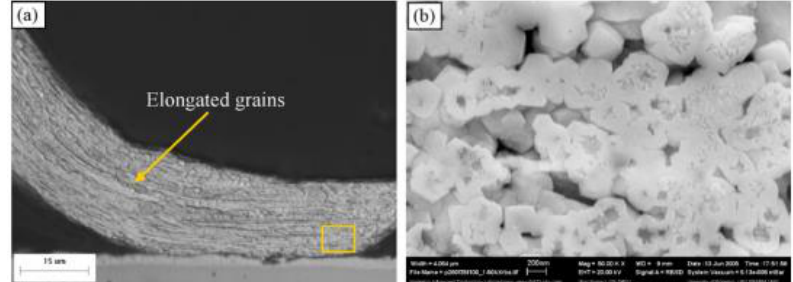
Figure 13. Microstructures of ultrasonically Cu-Al bonded joints. (Power = 323 mW, applied force = 35 gf, time = 50 ms. ( a ) Elongated Cu wire grains in the middle ( b ) high-resolution image of ( a ) showing the small equiaxed grains. Reproduced from [115], with permission of Elsevier.